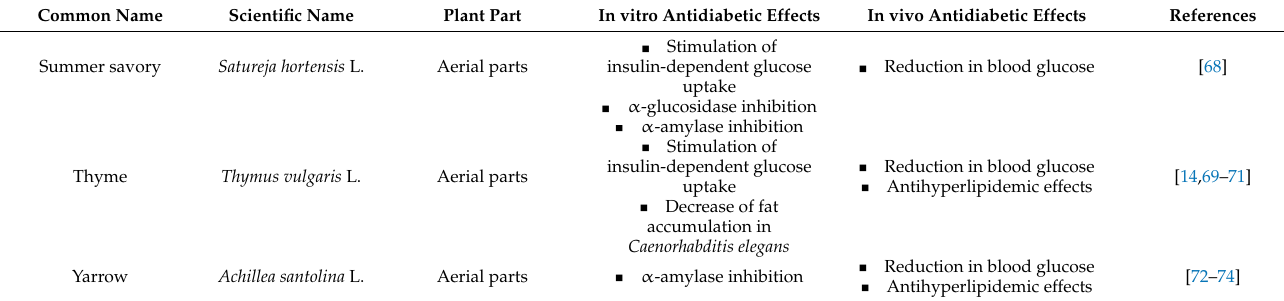
Table 1. A comprehensive summary of in vitro and in vivo antidiabetic properties of edible Medi- terranean plants.